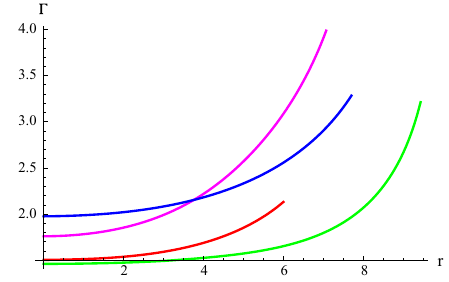
Fig. 6 Variation of adiabatic index versus r corresponding to MIT bag model EoS for different compact star